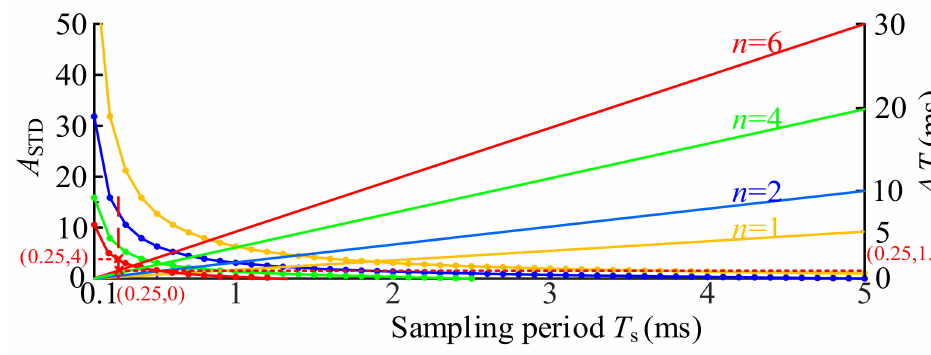
Figure 5. The relationship between ASTD and T s under different.